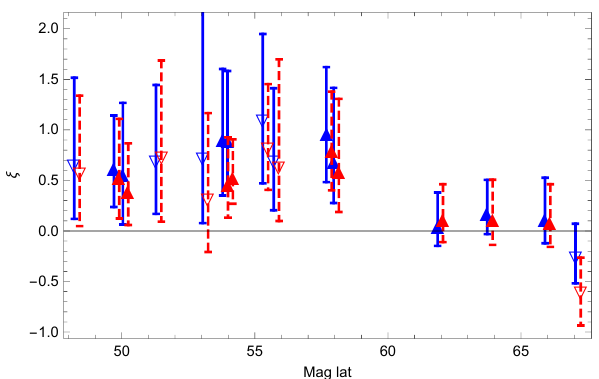
Figure 4. The figure shows the shape ξ as function of magnetic lati- tude for | d B / d t | (blue, solid) and E (red, dashed). Bars indicate er- ror limits at 95% confidence level estimated from the profile. Filled upward pointing triangles and unfilled downward pointing triangles mark stations with more than and less than 25years of data, respec- tively.